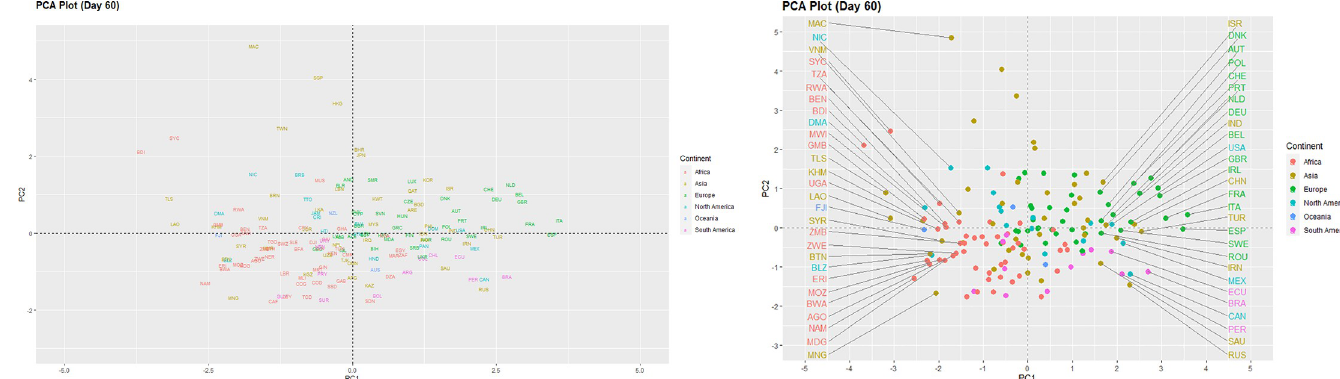
Fig 2. PCA plot (Day